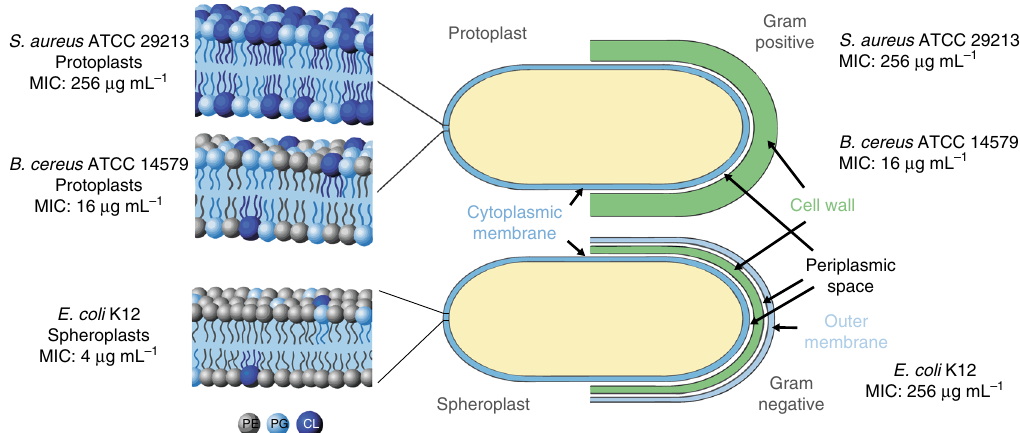
Fig. 3 Effect of 1 in Gram-positive bacteria/protoplasts and in Gram-negative bacteria/spheroplasts. Phosphatidylethanolamine (PE) — depicted in gray; phosphatidylglycerol (PG) — depicted in light blue; cardiolipin (CL) — depicted in